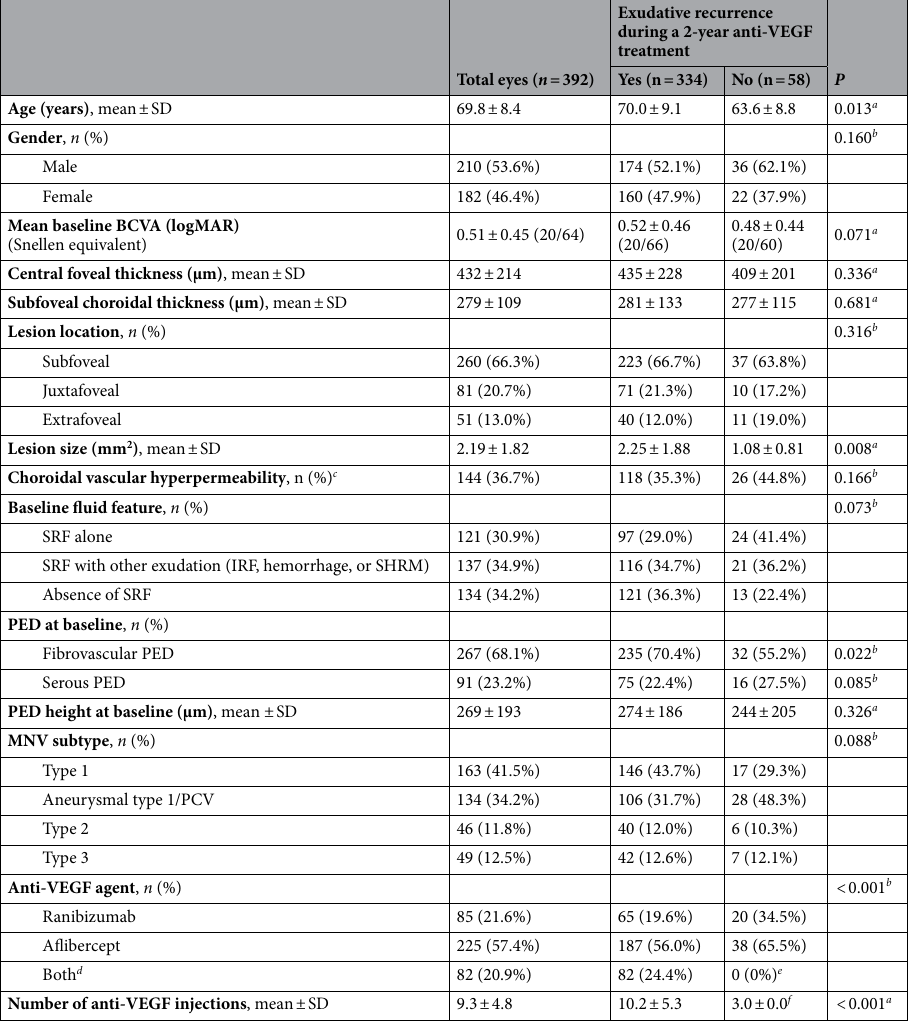
Table 1. Baseline characteristics of patients. AMD age-related macular degeneration, BCVA best-corrected visual acuity, IRF intraretinal fluid, logMAR logarithm of the minimum angle of resolution, MNV macular neovascularization, PCV polypoidal choroidal vasculopathy, PED pigment epithelial detachment, SD standard deviation, SHRM subretinal hyperreflective material, SRF subretinal fluid, VEGF vascular endothelial growth factor. a Student’s t-test. b Chi-square test. c Of all eyes, 39 indocyanine angiographic images were not available.